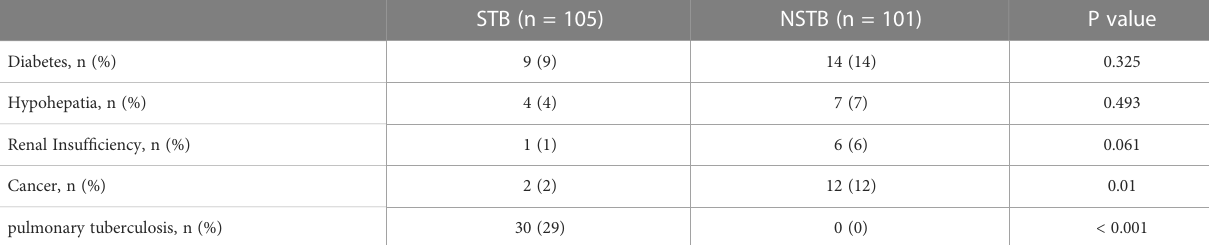
TABLE 2 The clinical characteristics of recruited patients.